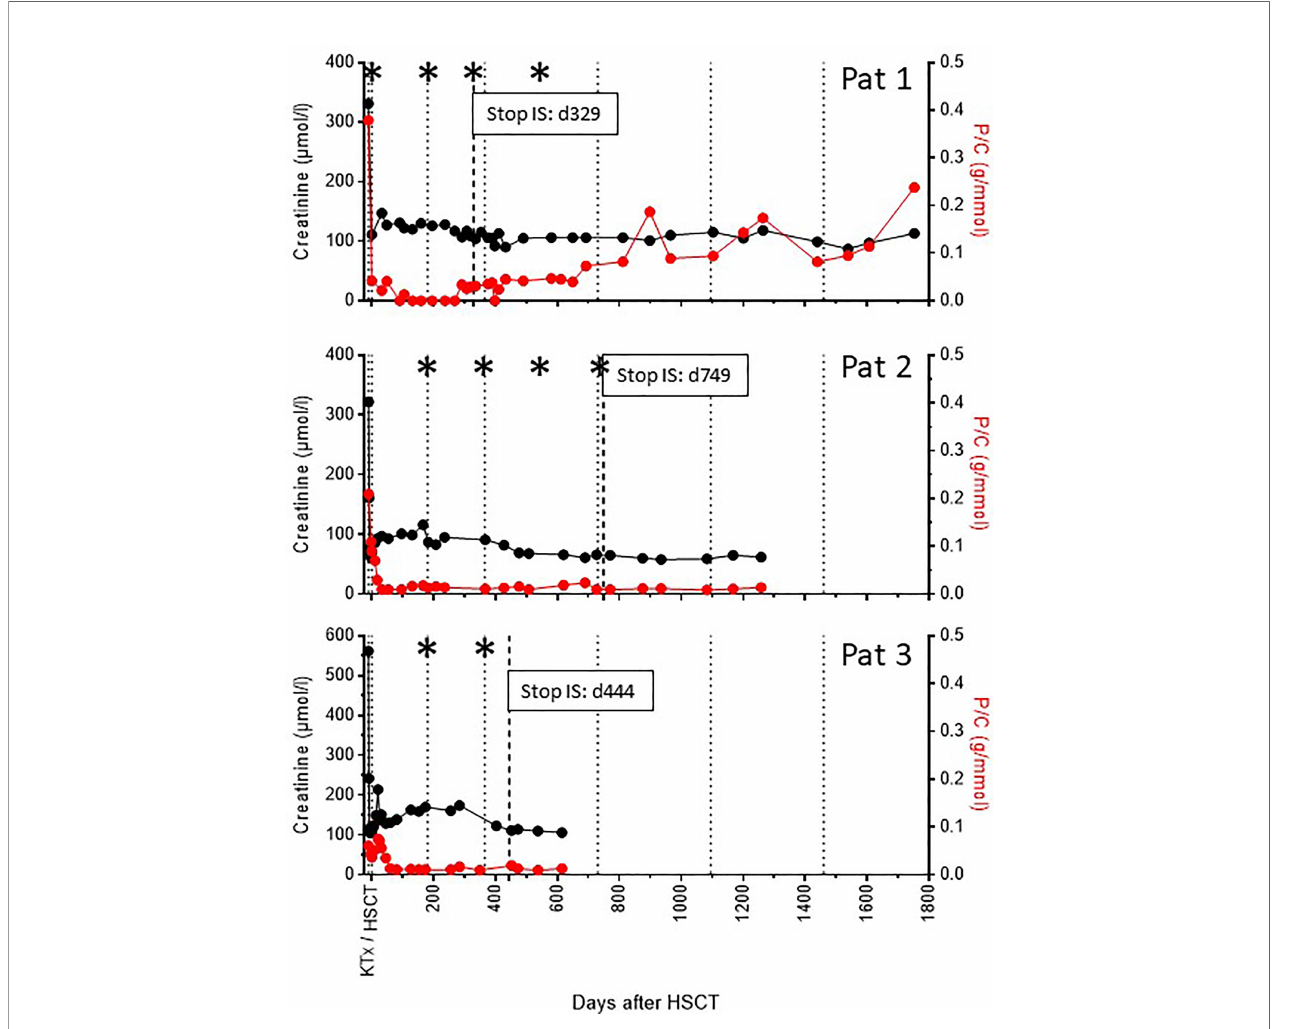
FIGURE 2 | Synopsis of renal function and proteinuria over time. The course of allograft function (serum creatinine, black dots) and proteinuria (protein/creatinine ratio, red dots) over time is shown for all three recipients. Dotted lines indicate time intervals of 6 and 12 months post-transplant and yearly thereafter. The hatched line indicates the time point of stop of all immunosuppressive treatment (IS). Asterisks indicate time points of allograft biopsies (see also Supplementary Table 1